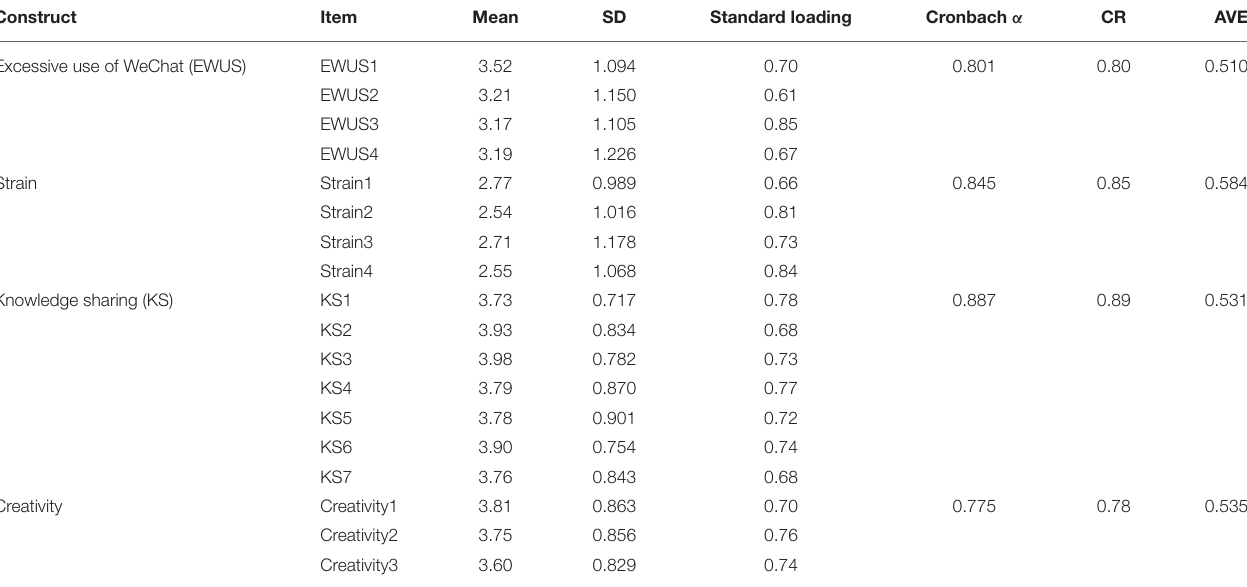
TABLE 3 | Mean, SD, reliability, and convergent validity. Construct